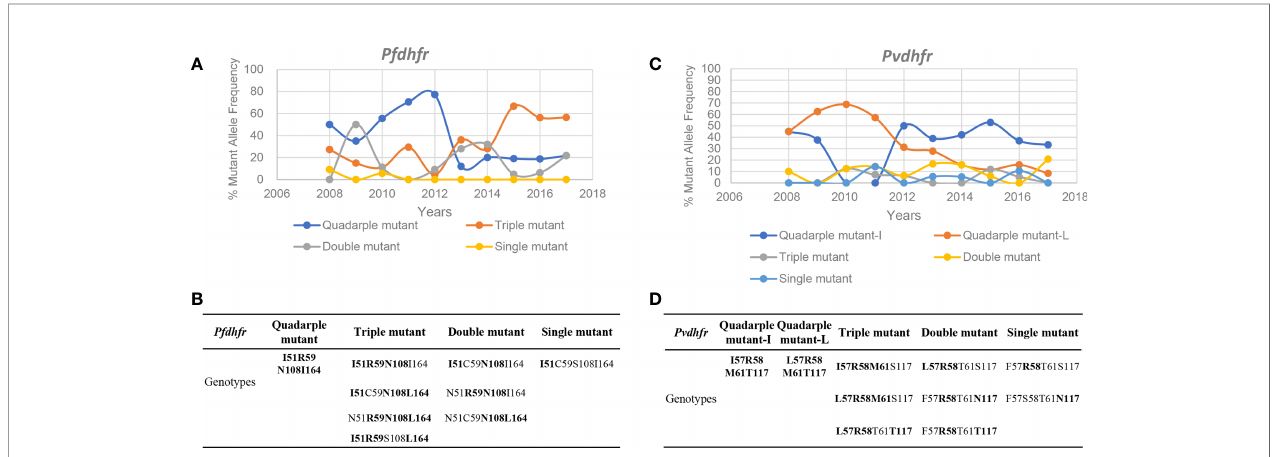
FIGURE 4 | Genotype frequency variation of pfdhfr and pvdhfr . (A, C) Popular tendency of all genotypes from 2008 to 2017 in pfdhfr and pvdhfr according to the list as given in (B, D) , respectively.